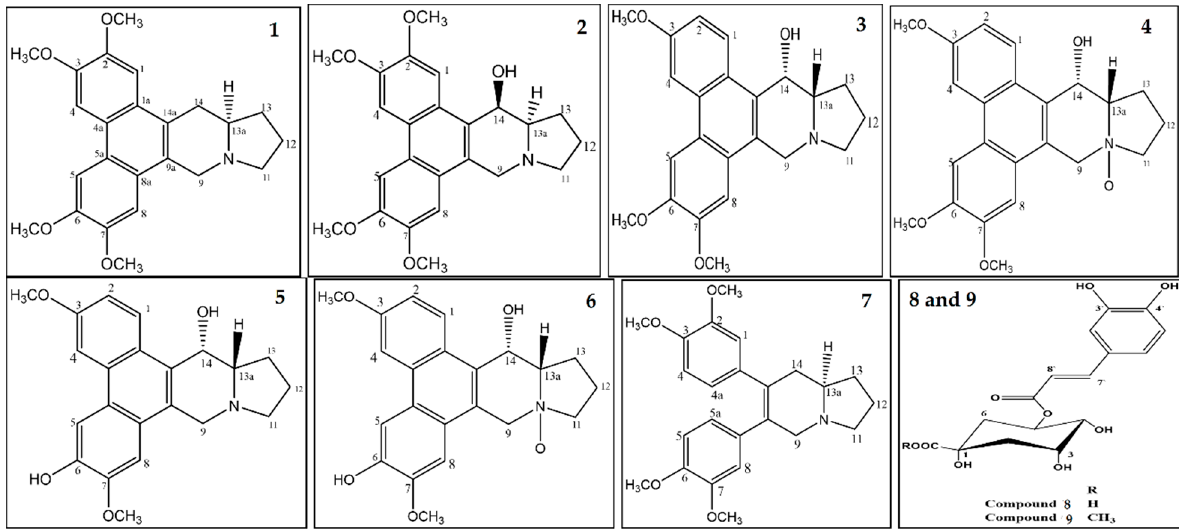
Figure 10. Structures of compounds ( 1 – 9 ), isolated and purified from the plant, Tylophora indica